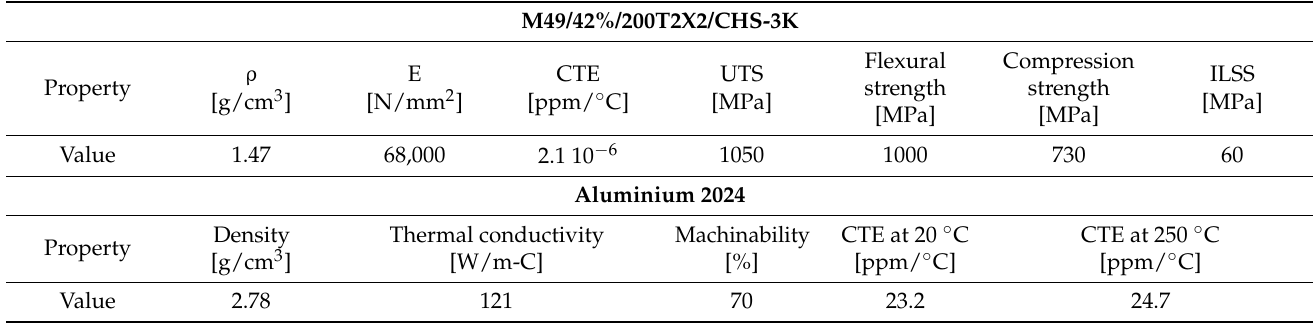
Table 1. Material properties